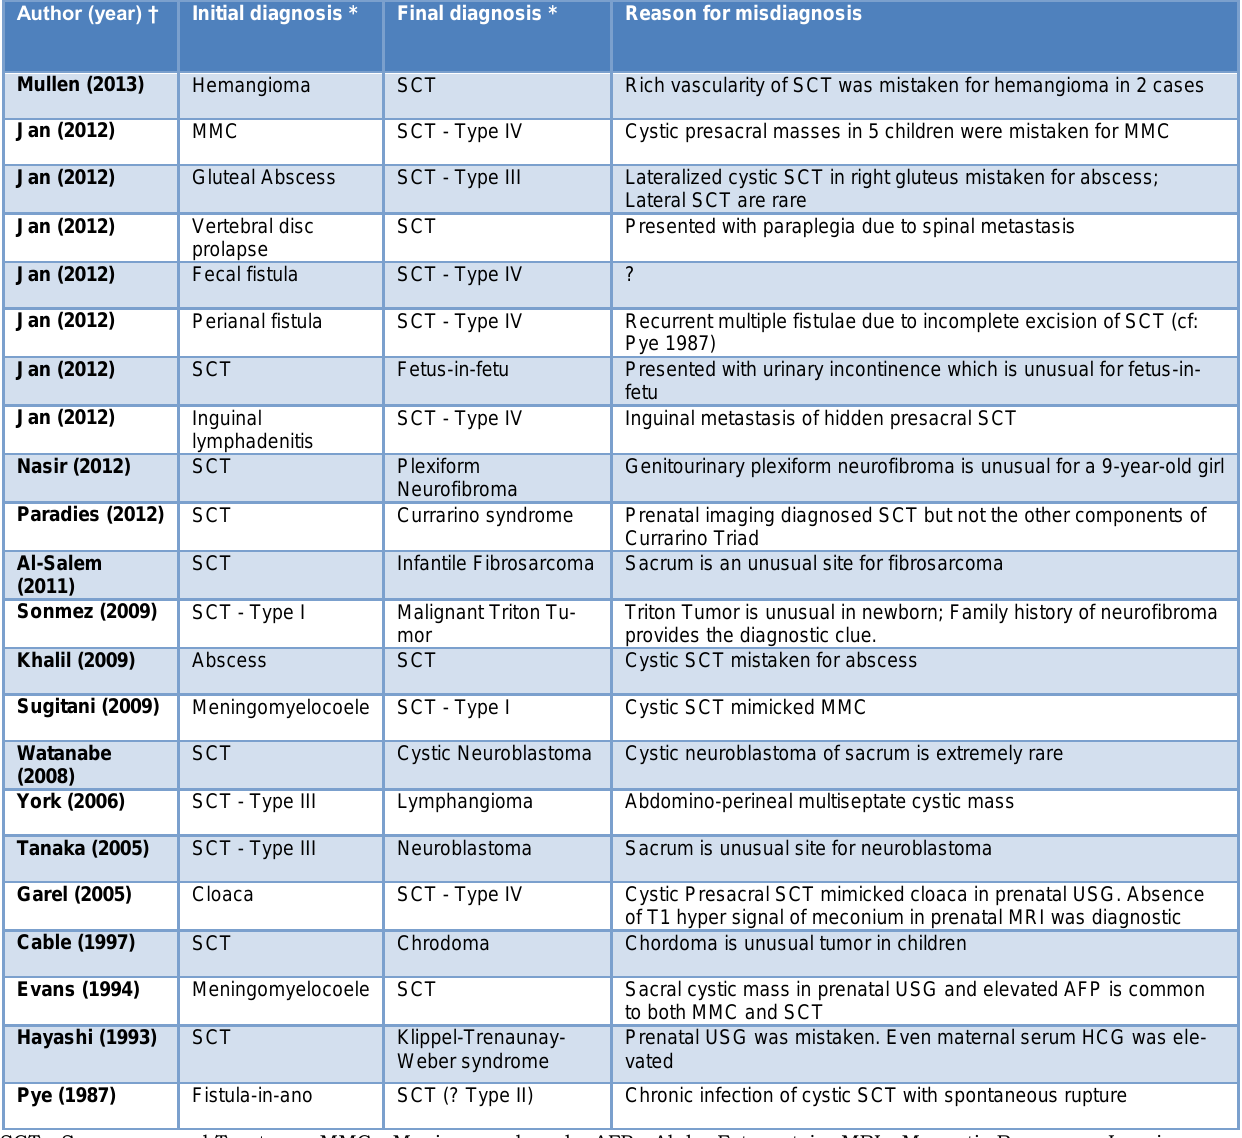
Table 1: Sacrococcygeal Teratoma - The great